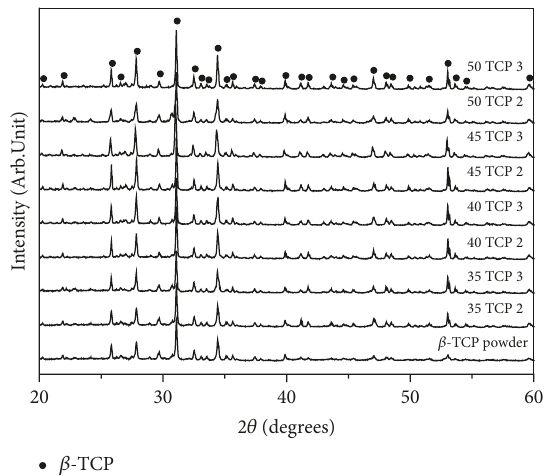
Figure 2: XRD pattern of the as-received 𝛽 -TCP powder and scaffolds with different w/v% and coating times after sintering.